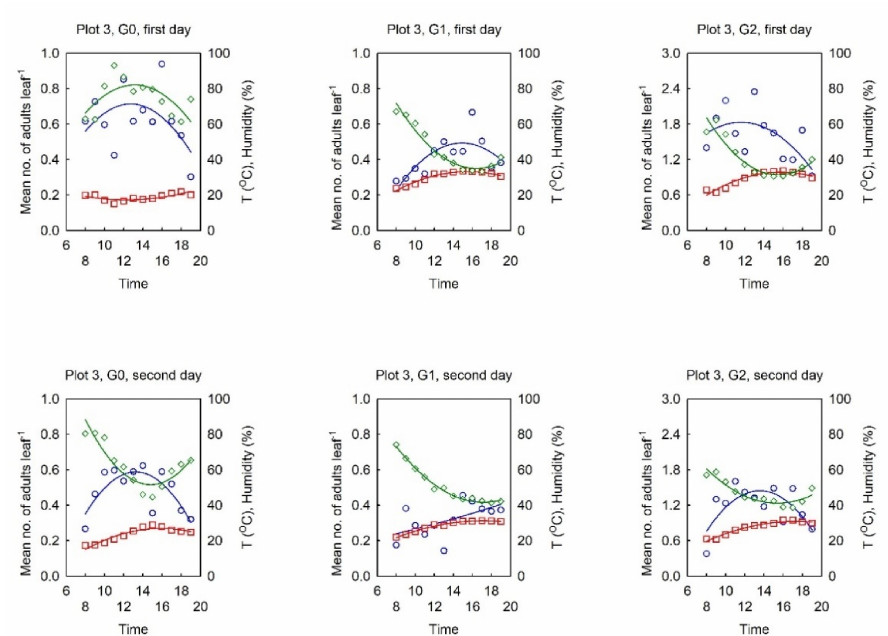
Figure 5. Dynamics of the diurnal activity of the OLB population in Plot 3 (Ceag ă u): G0 = win- tered population; G1 = first generation; G2 = second generation; blue = number of adults in flight; green = relative air humidity; red = air